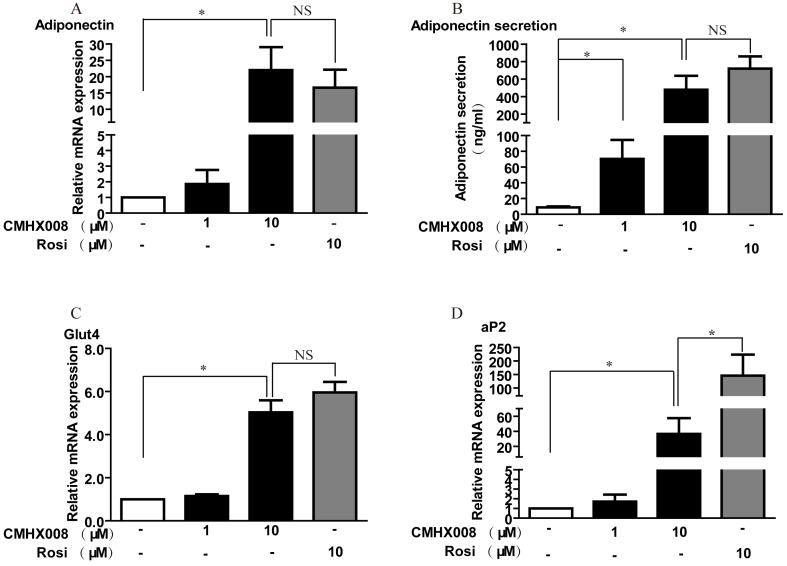
CMHX008 differentially regulates PPARγ target genes in 3T3-L1 adipocytes.Post-confluent 3T3-L1 preadipocytes were incubated in differentiation medium for 2 days. The medium was changed to DMEM containing insulin and 10% FBS for another two days and then replaced again with fresh DMEM containing 10% FBS for another 3 days. Rosiglitazone and CMHX008 were administered at the initiation of differentiation and with every medium change. At day 7, the differentiation cells were harvested for total RNA extraction and the mRNA expression of adiponectin (A), Glut4 (B) and aP2 (D) was analyzed by real-time PCR, and secreted adiponectin in the culture medium was measured using adiponectin ELISA kit (B). Data are the means ± S.E.M. from six independent experiments. *: P<0.05; NS: no significance.